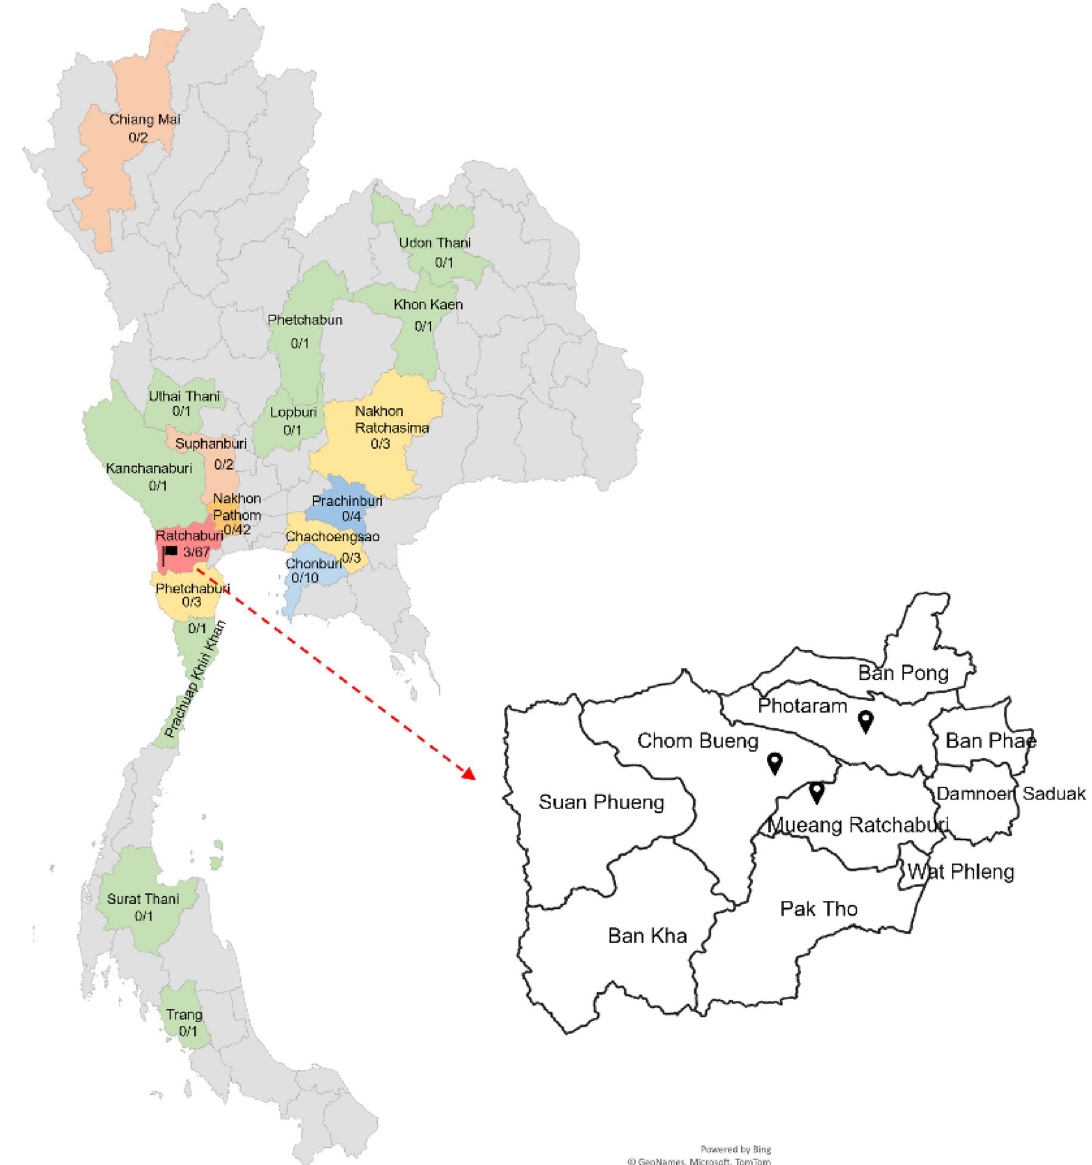
Figure 1. Geographic distribution of PCV4-tested swine farms (n = 145) in Thailand. The black flag indicates the Ratchaburi province where the positive samples were collected for complete genome sequencing. The locations of the 3 districts found PCV4-positive farms are indicated in the black